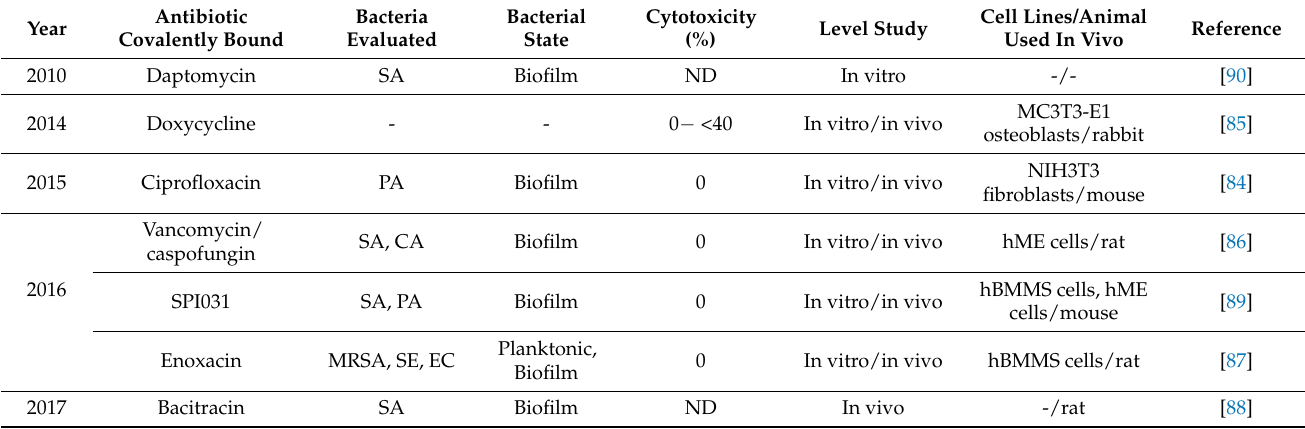
Table 2. Some of the most relevant studies based on antibiotic covalently bound to titanium surfaces.